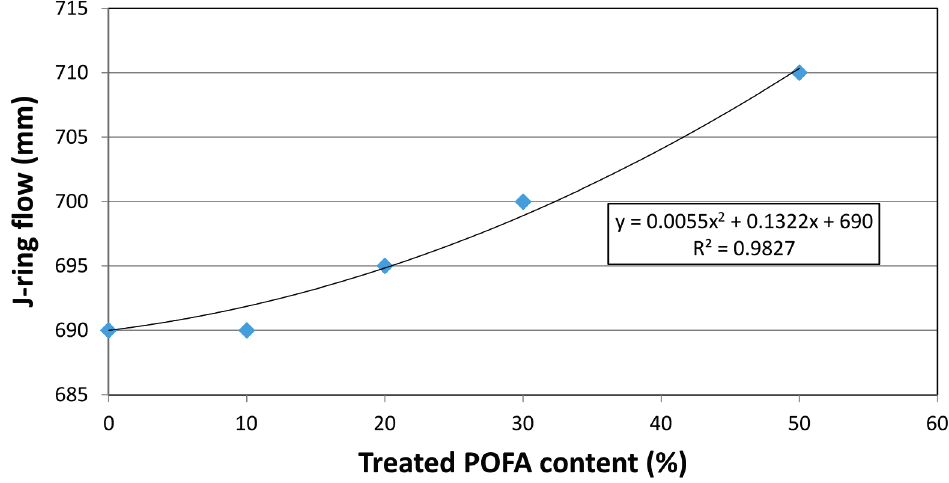
Figure 7. J-ring flow for SCC with treated